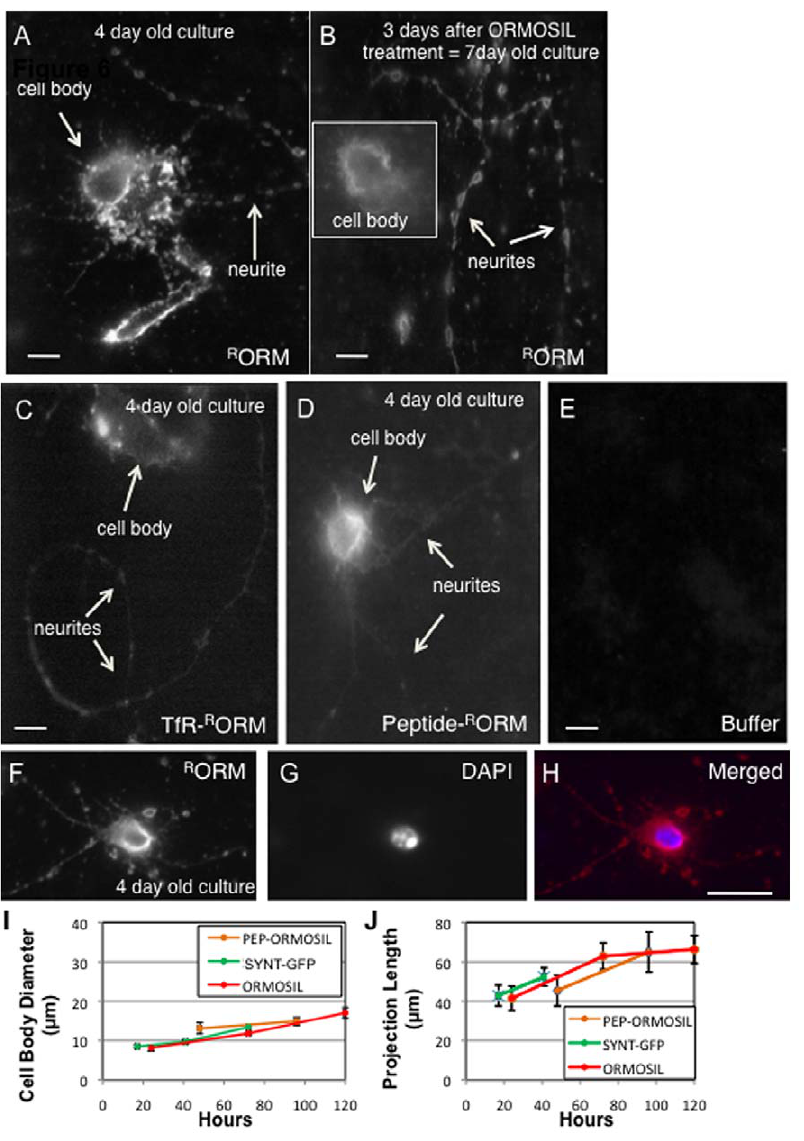
Figure 5. ORMOSIL incorporates into cell bodies and neuritis in primary neuronal cultures. (A) Unconjugated ORMOSIL is observed in 4 day old primary neuronal cultures. 4 day old primary neuronal cultures generated from larval brains were incubated with R ORM. Cultures were imaged using the 568 nm filter. R ORM is observed within the cytoplasm of the cell body in a discrete pattern and within neuritis (arrows). Images were taken using the 100 6 objective. Bar=5 m m. (B) Unconjugated ORMOSIL is also observed 3 days after ORMOSIL treatment. To determine how ORMOSIL affected the growth of cultures, ORMOSIL treated cultures were allowed to grow and again imaged after 3 days of ORMOSIL treatment. These cultures were now 7 days old. These treated cultures showed growth with very long neuronal projections compared to day 4. R ORM was still observed within the cell bodies (insert) and the neuritis (arrows,). Note that the fluorescence intensity at day 7 was similar to the intensity observed at day 4. Images were taken using the 100 6 objective. Bar=5 m m. (C) Receptor-conjugated ORMOSIL is observed in 4 day old primary neuronal cultures. 4 day old primary neuronal cultures generated from larval brains were incubated with transferrin receptor conjugated ORMOSIL (TfR- R ORM). TfR- R ORM can be observed within the cell body and within the neuritis. Images were taken using the 100 6 objective. No significant different in the distribution of ORMOSIL was seen between R ORM and TfR- R ORM treated cultures. Bar=5 m m. (D) Peptide -conjugated ORMOSIL is observed in 4 day old primary neuronal cultures. 4 day old primary neuronal cultures generated from larval brains were incubated with peptide-conjugated ORMOSIL (Peptide- R ORM). Peptide- R ORM can be observed within the cell body and within the neuritis. Images were taken using the 100 6 objective. No significant different in the distribution of ORMOSIL was seen between R ORM and peptide- R ORM treated cultures. Bar=5 m m. (E) Untreated control cultures. Control 4 day old cultures treated with buffer do not show fluorescence using the 568 nm filter. Images were taken using the 100 6 objective. Bar=5 m m. (F, G, H) ORMOSIL is absent from the cell body nucleus. 4 day old primary neuronal cultures were incubated with R ORM (F, red). Incubated cultures were fixed and stained with DAPI to localize the nuclei (G, blue). A representative merged image (H) indicates that ORMOSIL is absent from the cell body nucleus. Note that ORMOSIL is present in a discrete pattern within the cell body cytoplasm. Images were taken using the 100 6 objective. Bar=5 m m. (I) Quantification of cell body growth after ORMOSIL treatment. Graphs depict cell body growth for 120 hours (5 days) after ORMOSIL treatment. For untreated cultures, cultures expressing synaptotagmin-EGFP (SYNT-EGFP) was used. The effect of treatment was evaluated for unconjugated ORMOSIL (ORMOSIL) and for peptide-conjugated ORMOSIL (pep-ORMOSIL). For each time point 8–12 cells from three different experiments were analyzed. The average diameter and standard error was calculated and the average cell body diameter in microns was plotted against time in hours. No statistically significant difference was seen between ORMOSIL treated (unconjugated or peptide-conjugated) and